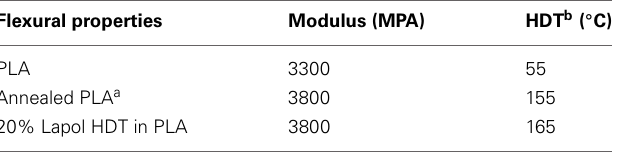
Table 5 | Comparison of flexural properties of Lapol® HDT blends